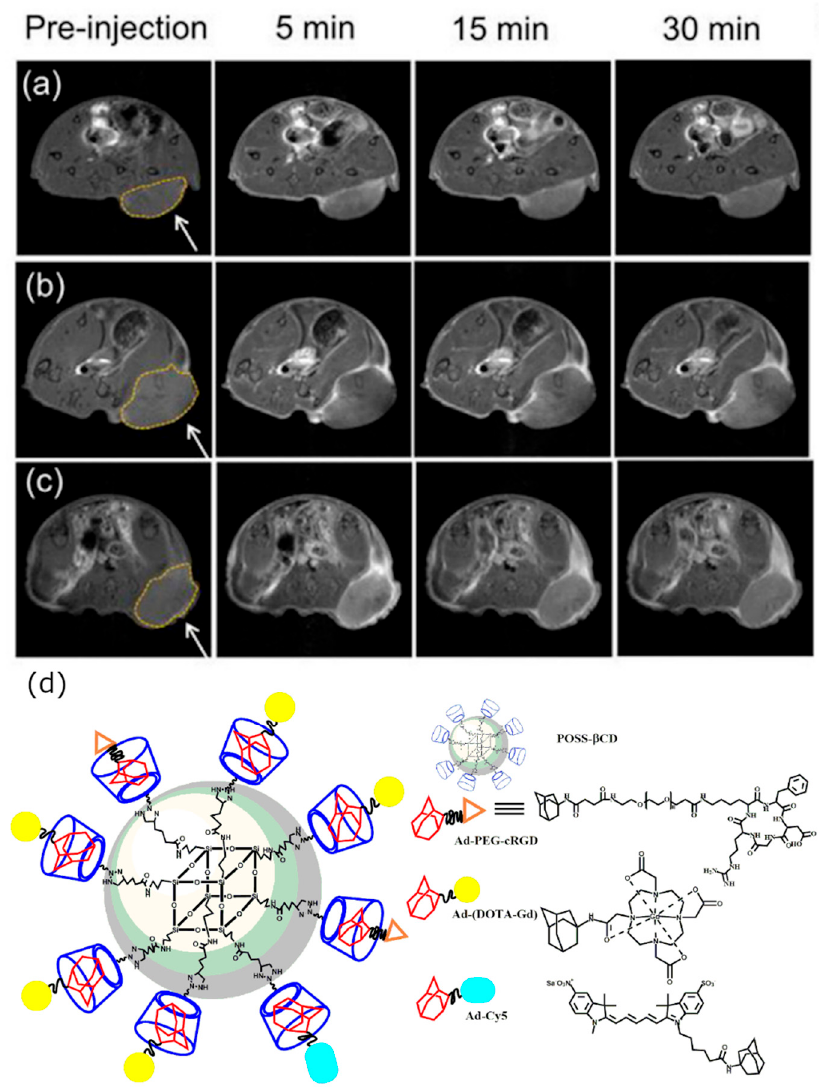
Figure 3. Magnetic resonance molecular imaging with cRGD-POSS- β CD-(DOTA-Gd)-Cy5 in mice bearing 4T1-Luc2-CFP tumor xenografts. The representative 2D axial fat-suppressed T1-weighted spin-echo MRI images before and at 5, 15, and 30 min post-injection of ProHance ( a ), cRAD-POSS-bCD-(DOTA-Gd)-Cy5 ( b ), and cRGD-POSS-bCD-(DOTA-Gd)-Cy5 ( c ) at 0.1 mmol-Gd / kg. The injection of cRGD-POSS- β CD-(DOTA-Gd)-Cy5 creates superior signal enhancement in tumor region. The images are reprinted with permission from publisher [67]. ( d ) Molecular structure of the developed cRGD-POSS- β CD-(DOTA-Gd)-Cy5 contrast agent.